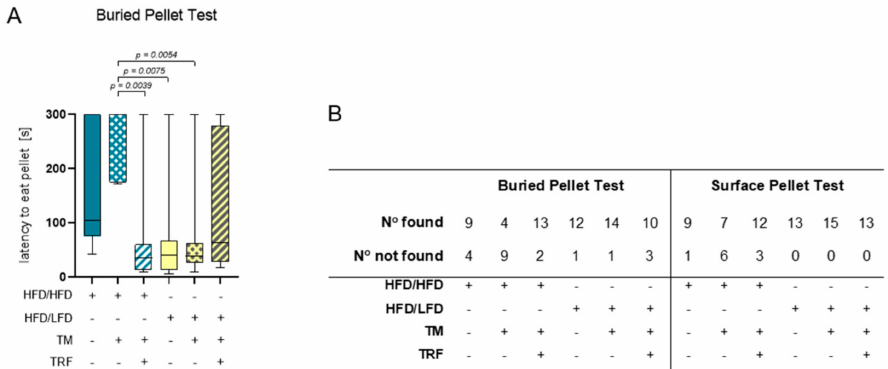
Figure 7. Results of the buried pellet test and surface pellet test. ( A ) Impaired sense of smell altered depending on intervention parameters. Boxplots indicate performance of HFD/HFD ( n = 13), HFD/HFD + TM ( n = 13), HFD/HFD + TM + TRF ( n = 15), HFD/LFD ( n = 13), HFD/LFD + TM ( n = 15) and HFD/LFD + TM + TRF ( n = 13). Significance of differences was tested by Kruskal–Wallis with Dunn’s post hoc test for multiple comparisons. Data are presented as mean ± SD and statistical significance was set at p < 0.05. ( B ) Results of finding and not finding pellets in the buried pellet test and surface pellet test. Abbreviations: HFD: high-fat diet, LFD: low-fat diet, TM: treadmill, TRF: time-restricted feeding.